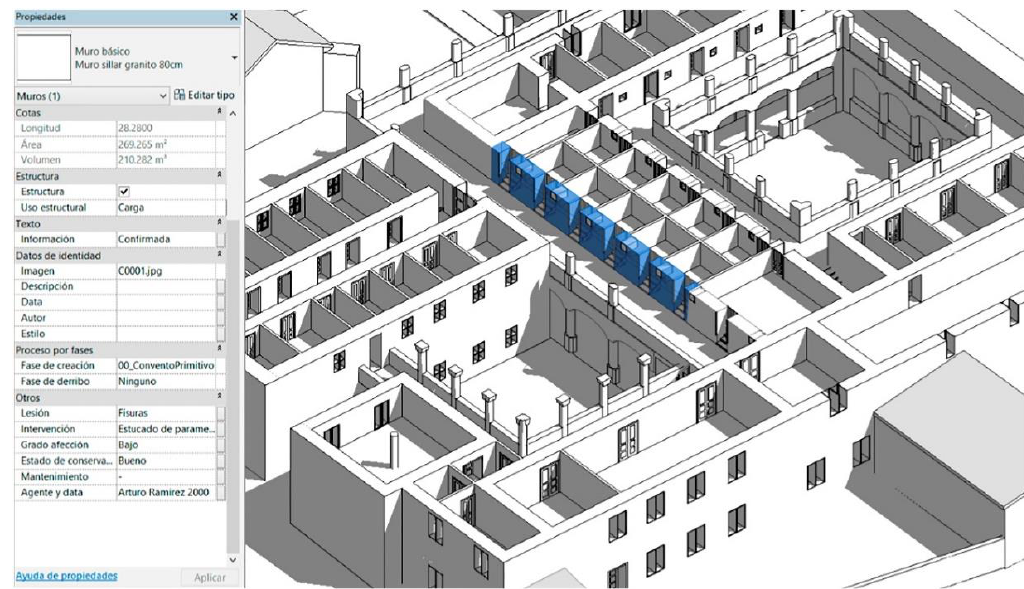
Figure 10. Study of the wall characteristics of the monastery, 2021.